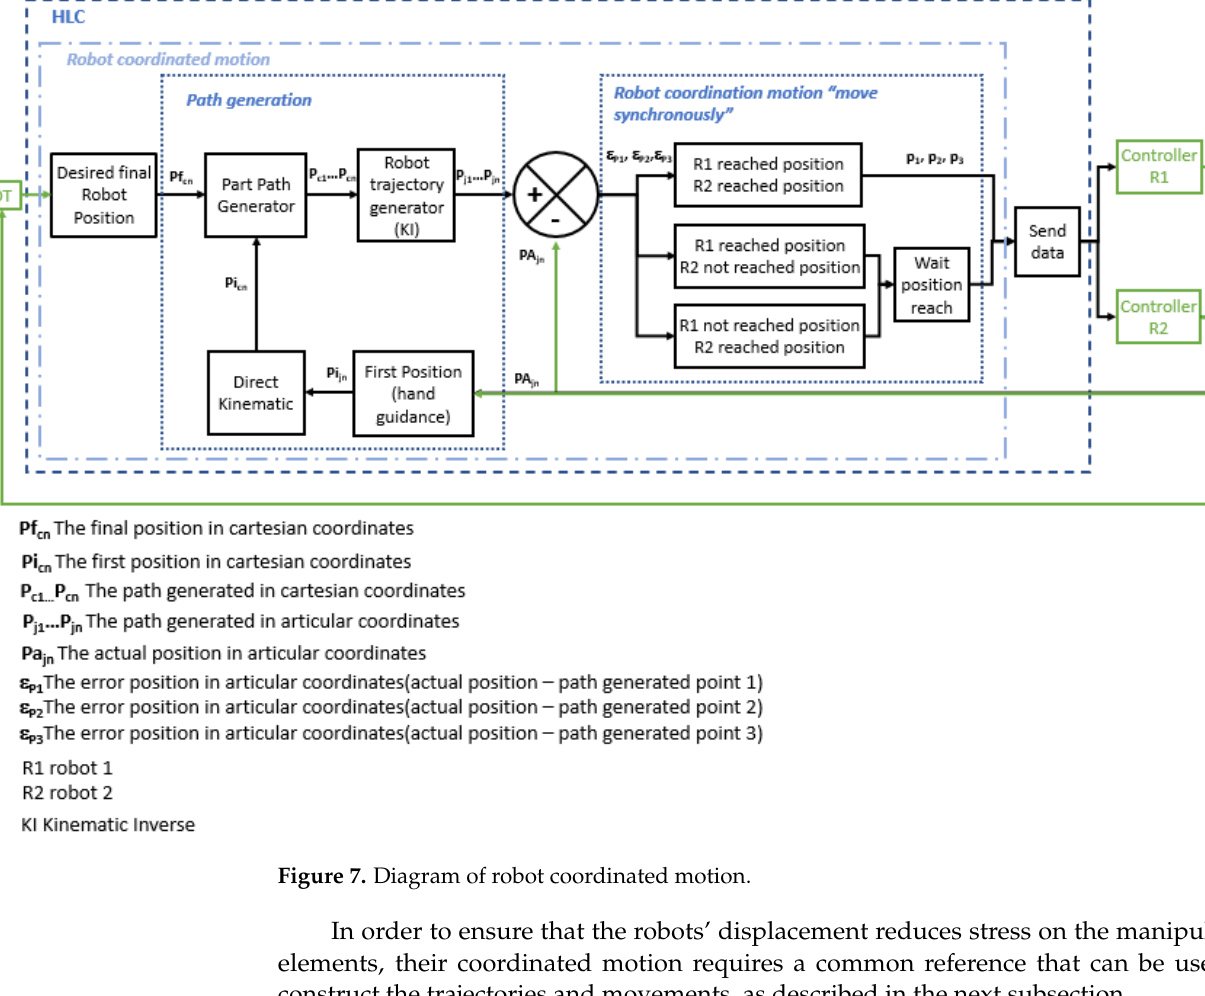
Figure 7. Diagram of robot coordinated motion.